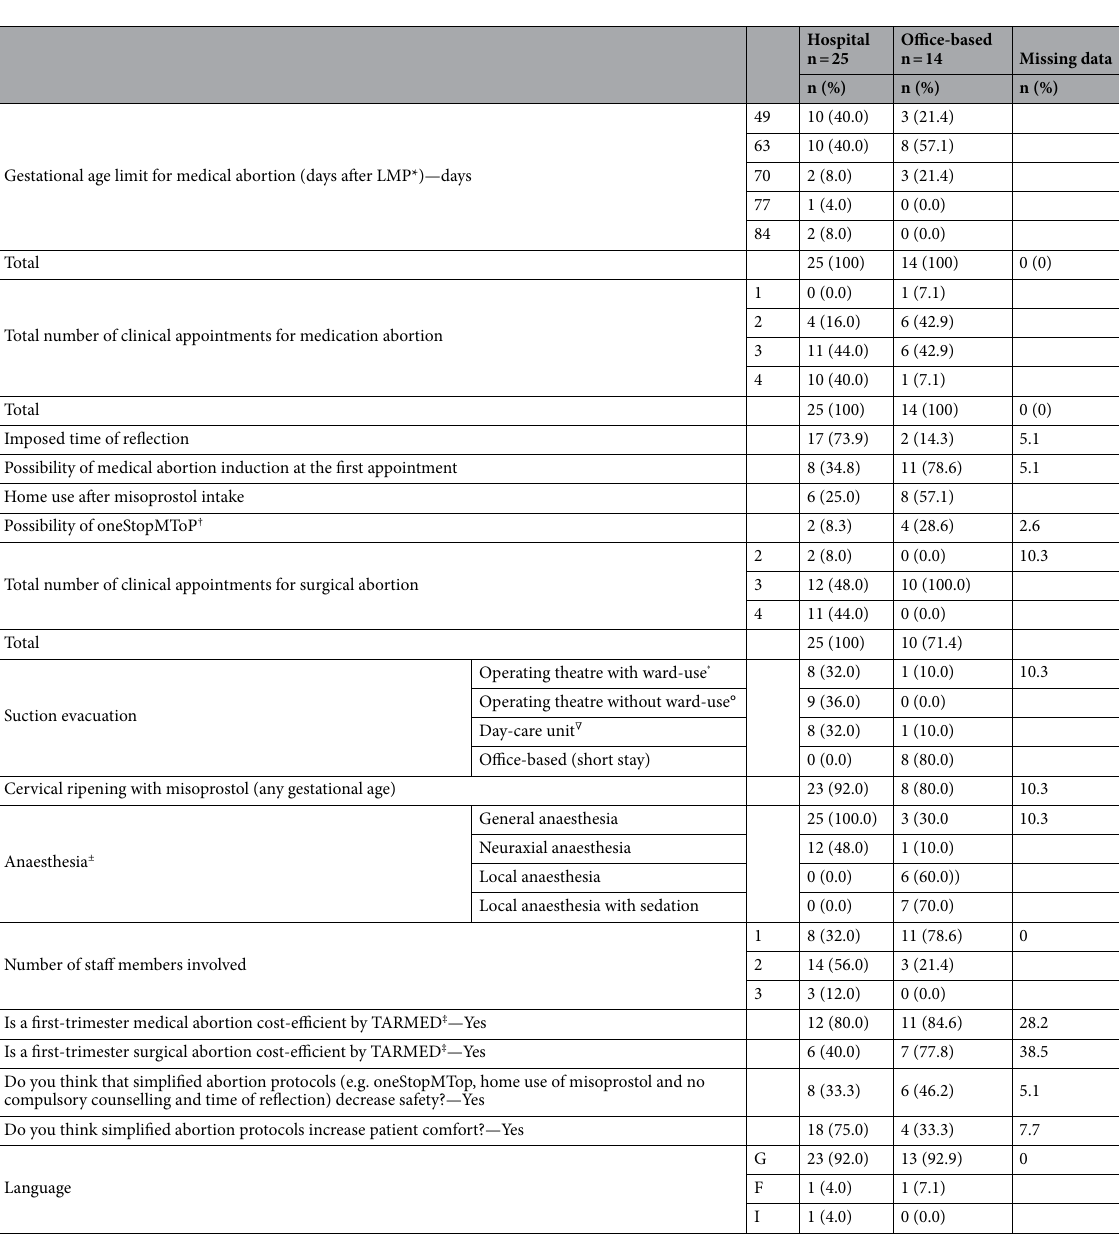
Table 2. Characteristics of abortion protocols by facility type (Hospital vs office-based). All data acquired from the questionnaires. G German, F French, I Italian; Group 1 Hospitals, Group 2 General Practitioners. *Last menstrual period. † One Stop (one consultation) for Medical Termination of Pregnancy. ‡ Swiss Fee-for- Service-System. ⋄ Patient transferred from theatres to impatient ward and discharged from there (ward staff involved). °Patient transferred from theatres to recovery and discharged from there. ∇ Patient transferred from theatres to day-care ward for outpatient procedures and discharged from there. ± Multiple answers